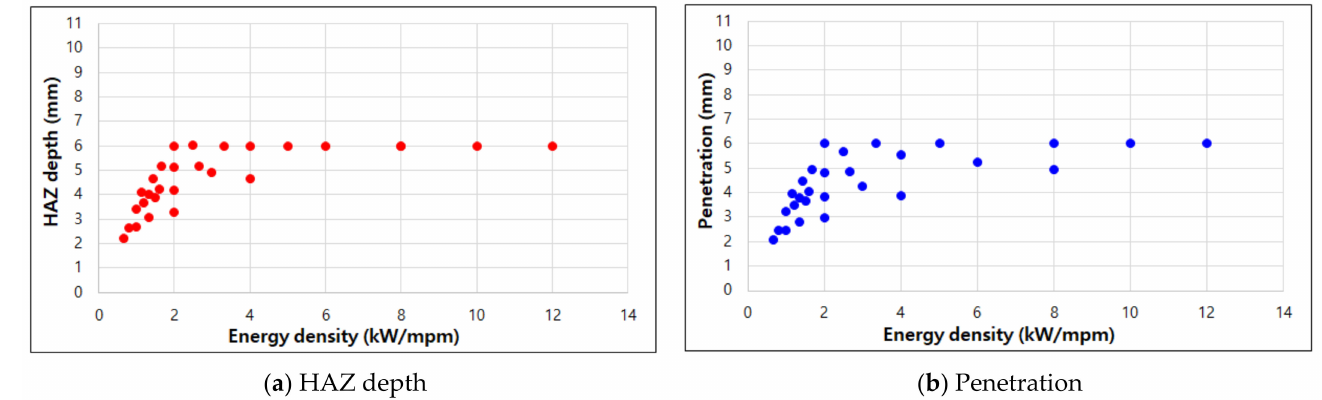
Figure 8. Relationship between energy density and HAZ depth,